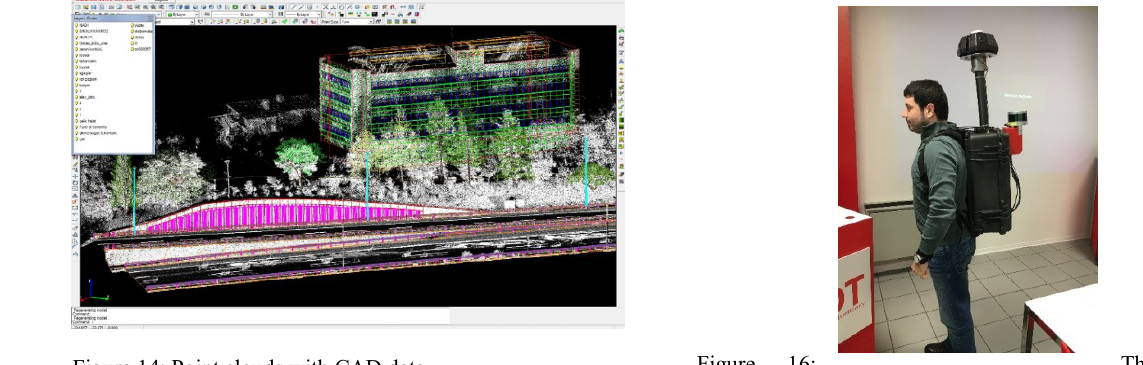
Figure 14: Point clouds with CAD data.